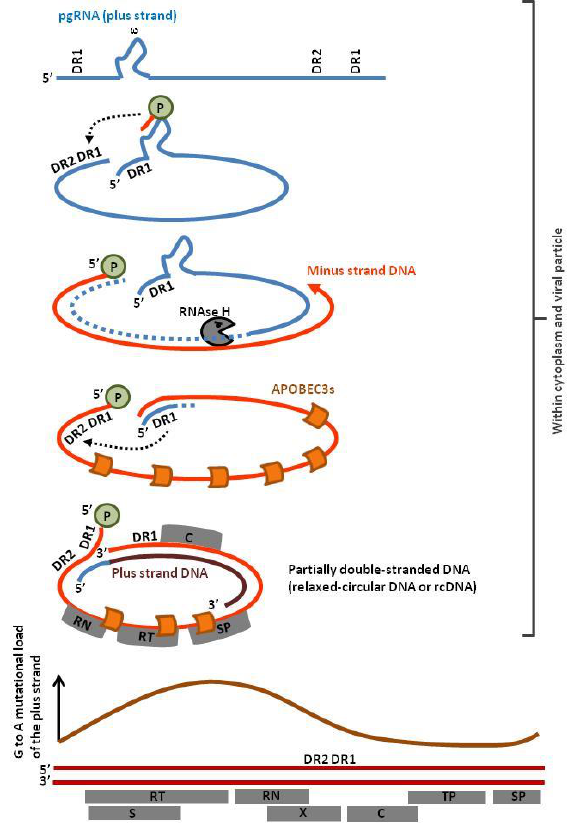
Figure 5. Profile of APOBEC3 editing of the HBV genome. The viral P protein